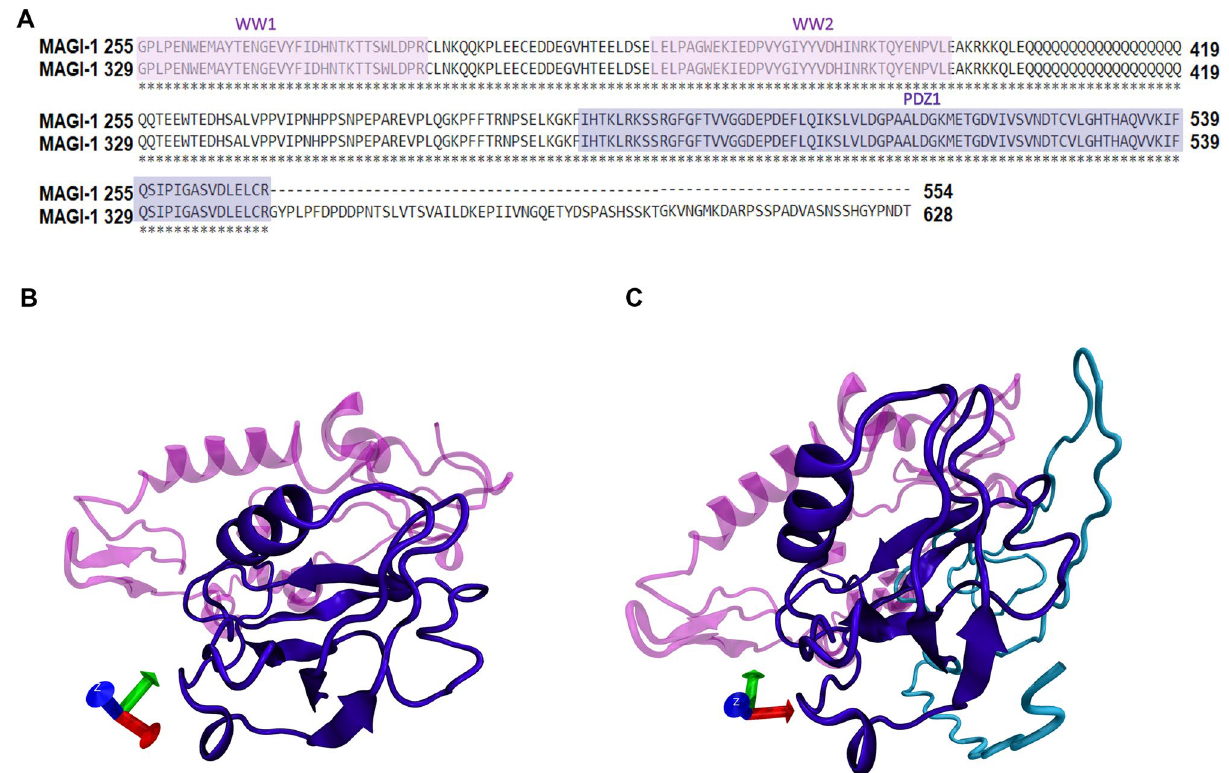
Figure 2. 3D structure of MAGI-1 255 and MAGI-1-329 models. ( A ) Multiple alignment of the sequence of model MAGI-1 255 and MAGI-1 329 highlighting domains WW1 and WW2 in soft pink and domain PDZ1 in soft purple. ( B ) 3D model visualization of MAGI-1 255 ( C ) 3D model visualization of MAGI-1 329. The WW1 and the WW2 domains are shown in light pink, the PDZ1 domain is shown in violet, and a highly disordered region of 76 amino acids in